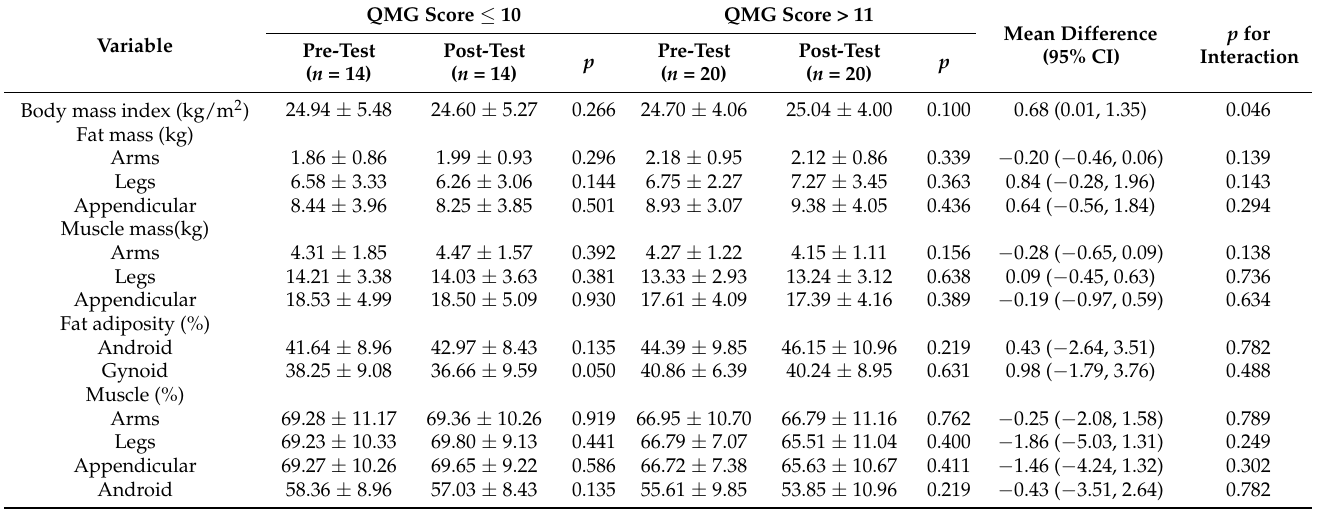
Table 6. Body composition in patients with MG before and after resistance training according to QMGS score.